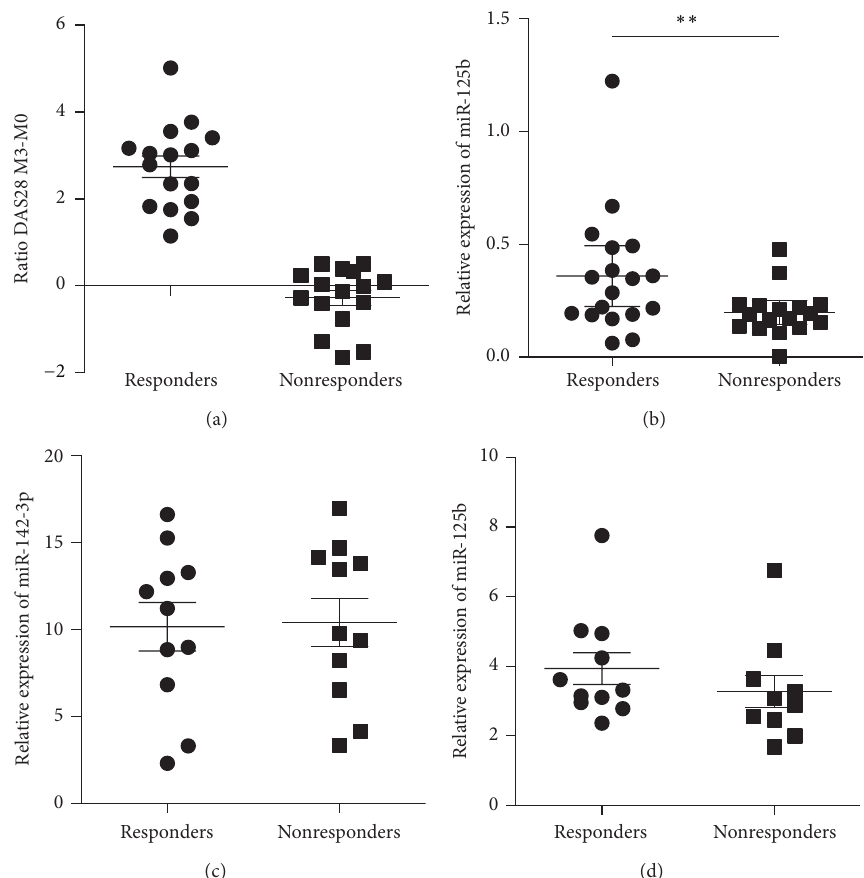
Figure 3: miR-125b as predictive biomarker for rituximab treatment outcome in RA. (a) DAS28 M3-M0 represents the difference at baseline versus 3 months after rituximab treatment. Patients were considered nonresponders (NR, 𝑛 = 16 ) or responders (R, 𝑛 = 16 ) according to EULAR criteria. Serum mature miR-125b (b), miR-142-3p (c), and miR-142-5p (d) are quantified in RA patients according to their clinical response. ∗ 𝑃 < 0.05 , ∗∗ 𝑃 < 0.01 as determined by Mann-Whitney